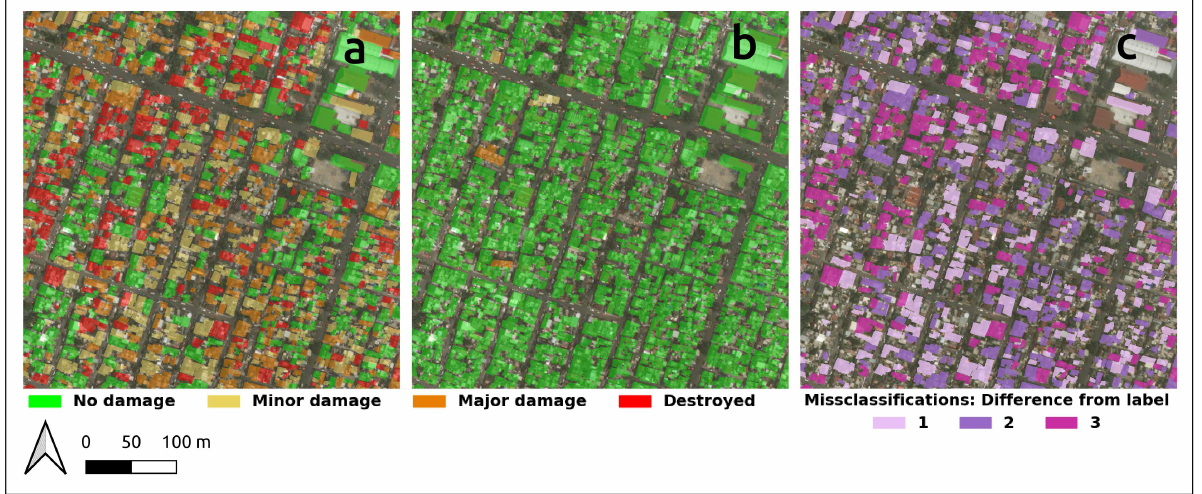
Figure 6. Application of ProtoNet model on a test case from Mexico 2017. Satellite image overlaid with: ( a ) the predictions, ( b ) the labels and ( c ) the difference between the